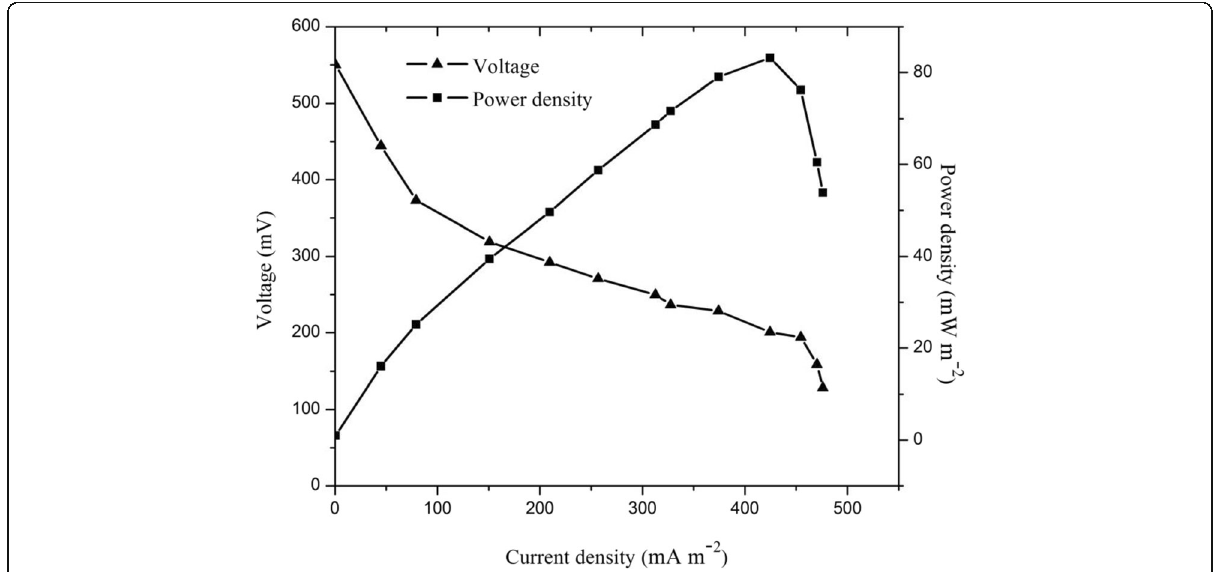
Fig. 3 Plots of voltage and power density against current